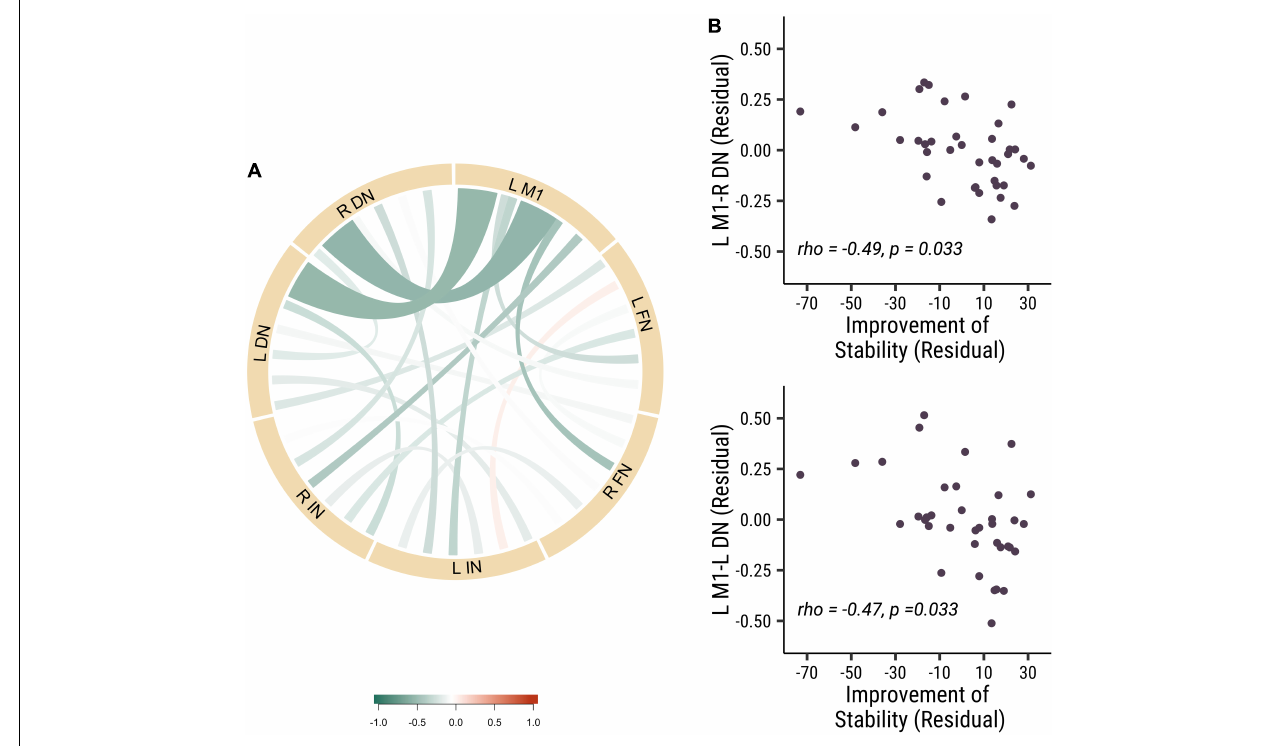
FIGURE 3 | The baseline functional connectivity of M1 to dentate, fastigial, and interposed nucleus, corelated with the improvement of stability. (A) The correlation of different functional connectivity and the stability improvements in all participants. (B) The correlation between functional connectivity of L M1-R DN (rho = –0.49, p = 0.033; top panel) and L M1-L DN (rho = –0.47, p = 0.033; bottom panel) functional connectivity and the improvement of stability. Each point is one participant. (L M1 = left motor cortex; R DN = right dentate nucleus; L DN = left dentate nucleus; R FN = right fastigial nucleus; L FN = left fastigial nucleus; R IN = right interposed nucleus; L IN = left interposed